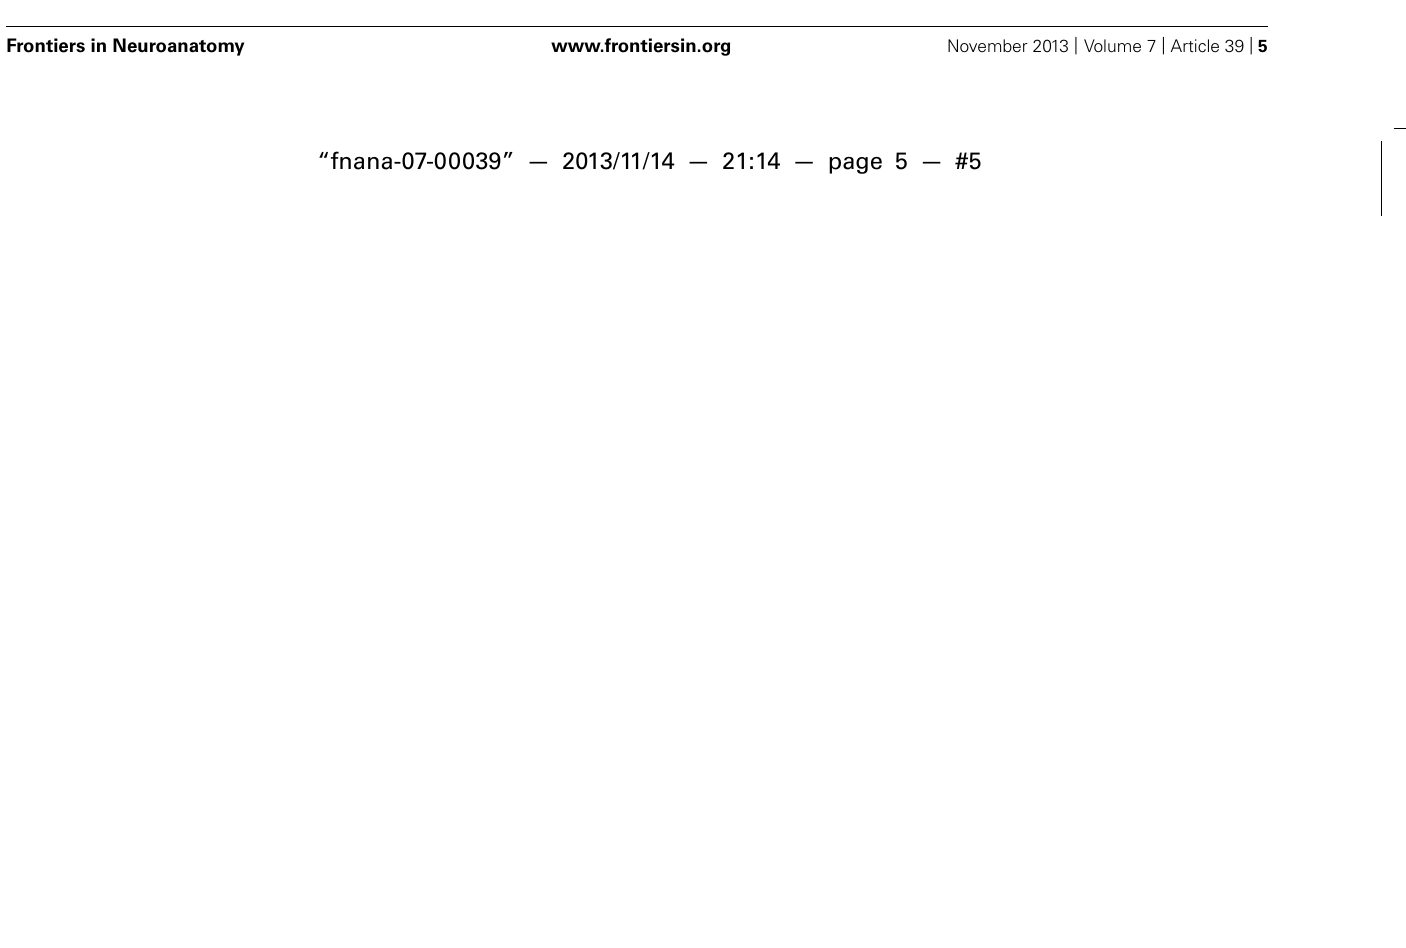
FIGURE 2 |Topography of the naked mole-rat cerebellum with electrophysiological mapping of cutaneous and periodontal responses from the ansiform lobule, vermis, pyramis and uvula. (A) Schematic of the microelectrode-derived map of cutaneous inputs to the cerebellum labeled according to corresponding receptive fields. Dark circles outline sites injected